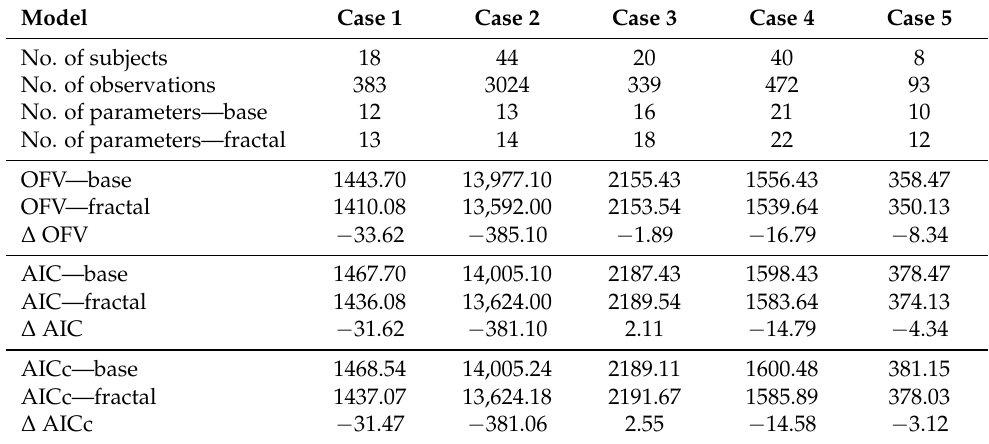
Table 2. Summary of the performance metrics in the estimation